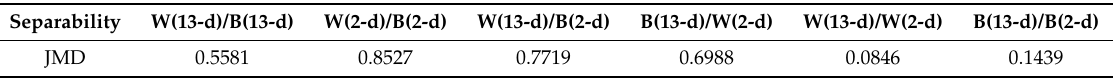
Table 7. Jeffries-Matusita Distance (JMD) scores showing separation for data gathered from 13-dimensional parameters and a two-dimensional interface using warm (W) and bright (B) examples. Higher scores are desirable for the first four measurements, while lower scores are better for the last two columns.